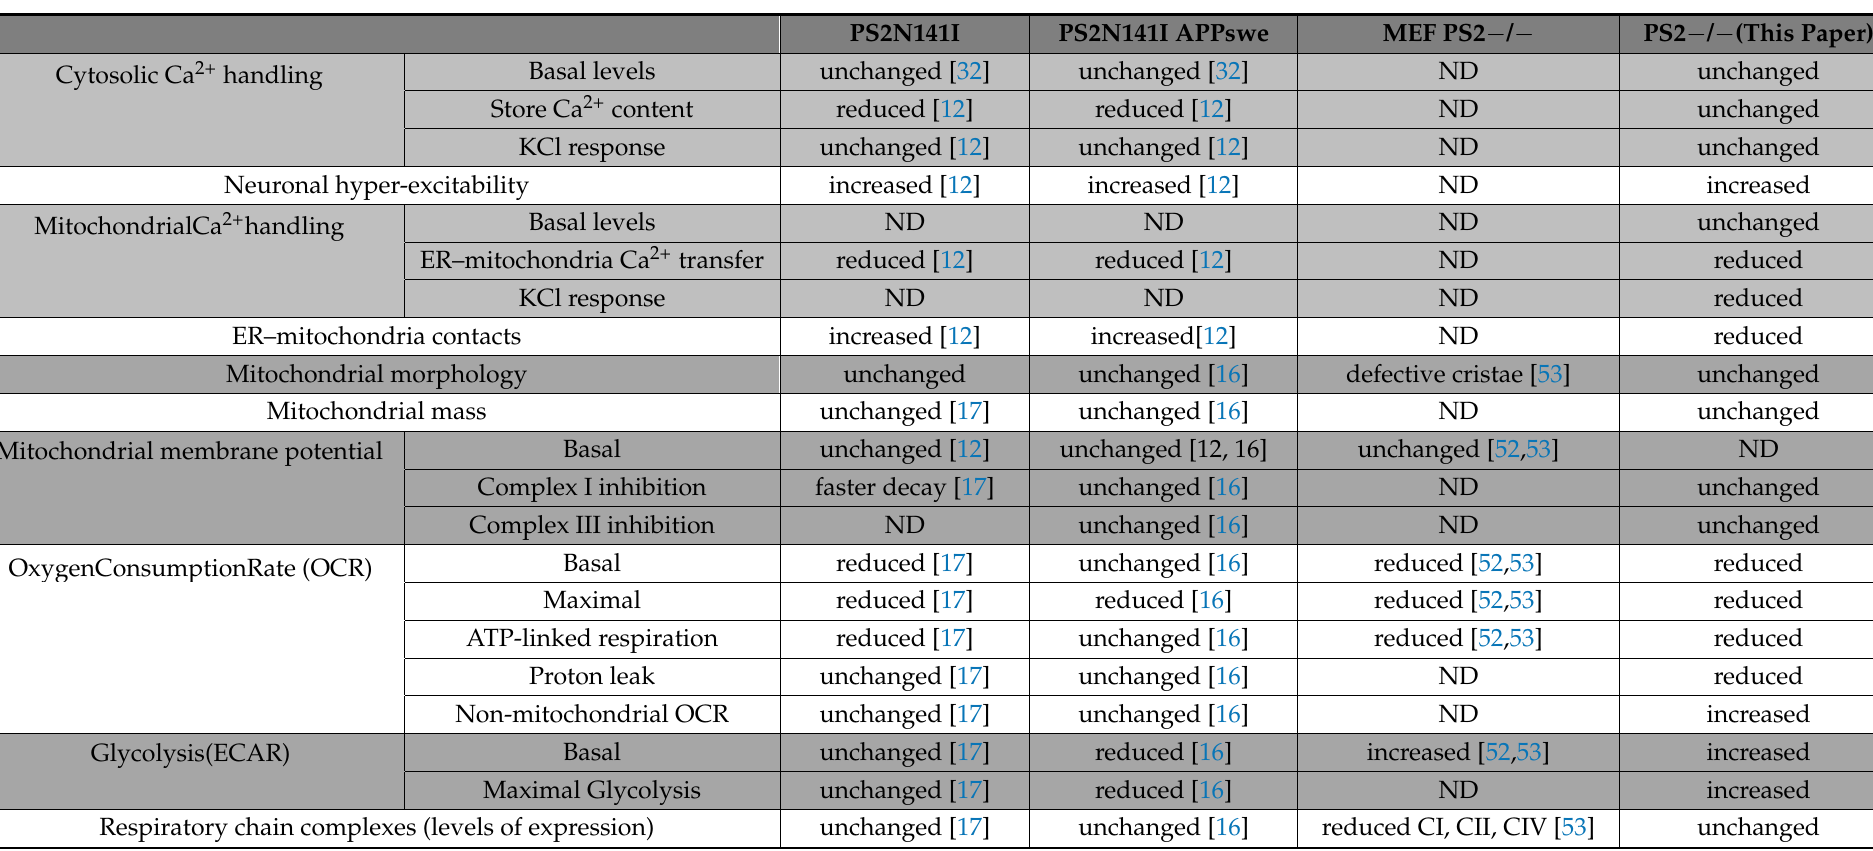
Table 1. The table summarizes the Ca 2+ handling and mitochondrial bioenergetics parameters analyzed in PS2–/–, Familial Alzheimer’s disease (FAD)-PS2 expressing neurons and mouse embryonic fibroblasts (MEFs) PS2–/–, compared to WT. ND = not